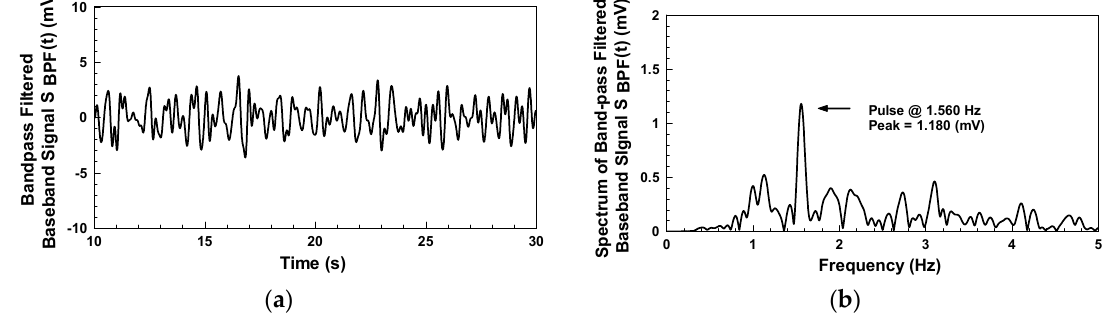
Figure 11. Pulse detection results for the subject wearing a long-sleeved shirt: ( a ) Bandpass-filtered baseband signal; ( b ) Spectrum of Figure 11a.